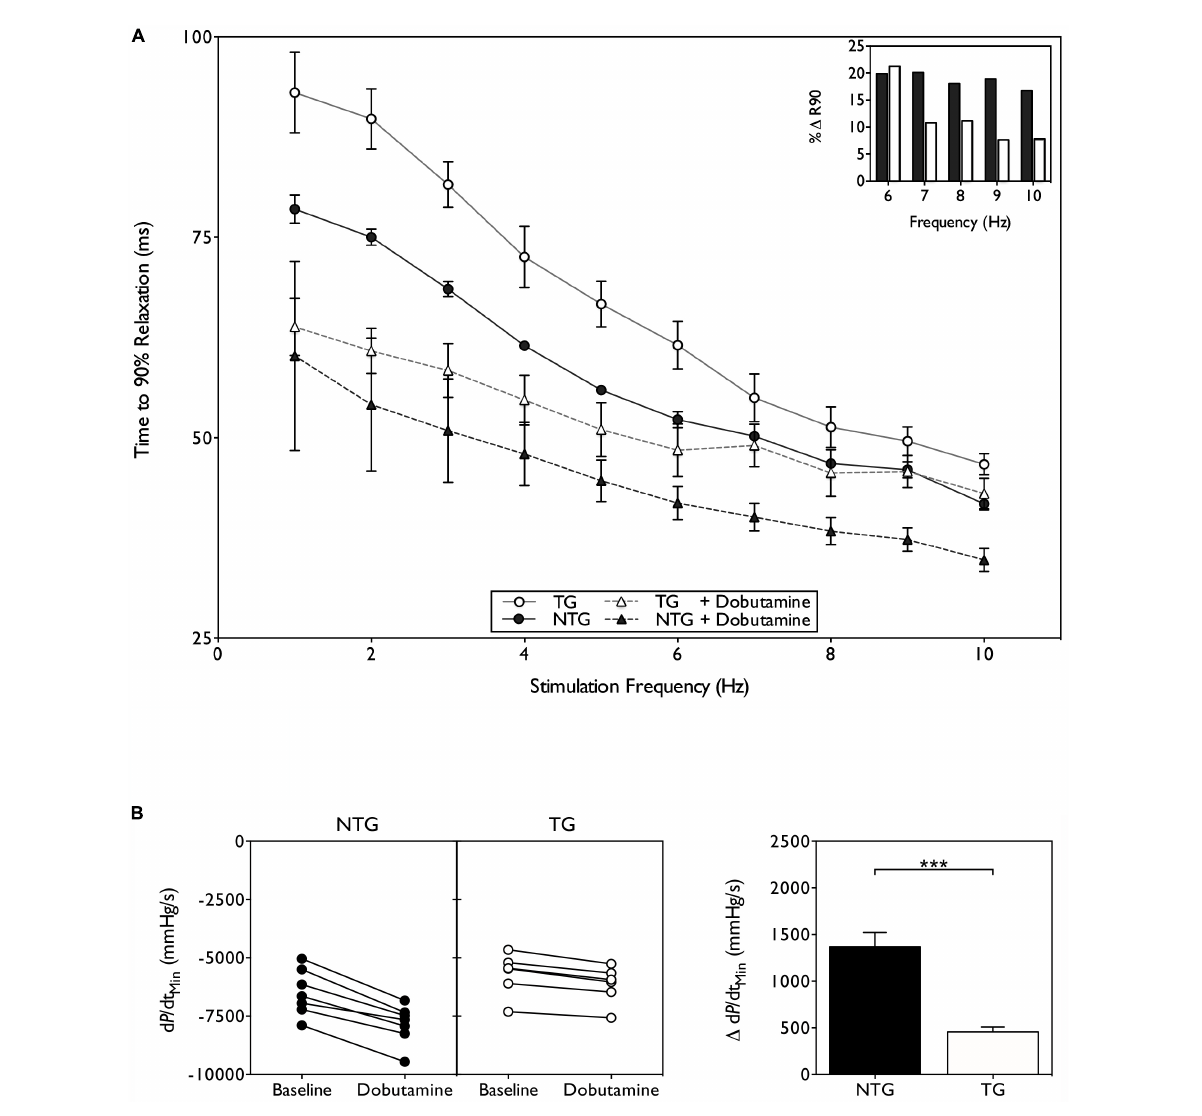
FIGURE2 Suppression of lusitropy in ACTC E361G transgenic mouse. (A) Effect of dobutamine on intact papillary muscle contractility. Papillary muscles, isolated from both ACTC E361G ( n = 5) and NTG mice ( n = 5), were stimulated with the addition of 10 µ M dobutamine to the perfusion solution at 37 ◦ C. Time to 90% relaxation is plotted against stimulation frequency; (inset) percent change of ttb 90 with dobutamine treatment at physiologically relevant frequencies. (B) The effect of acute dobutamine treatment on cardiac performance determined by Millar catheter. Data are presented as mean ± SE of 6 ACTC E361G (open bars) mice and 7 NTG (solid bars) mice. The change of rate of pressure decline (dP/dtmin) on treatment with dobutamine is plotted (left) and mean values plotted in a bar chart (right). *** P = 0.001, unpaired student’s t -test. Data from Wilkinson et al.